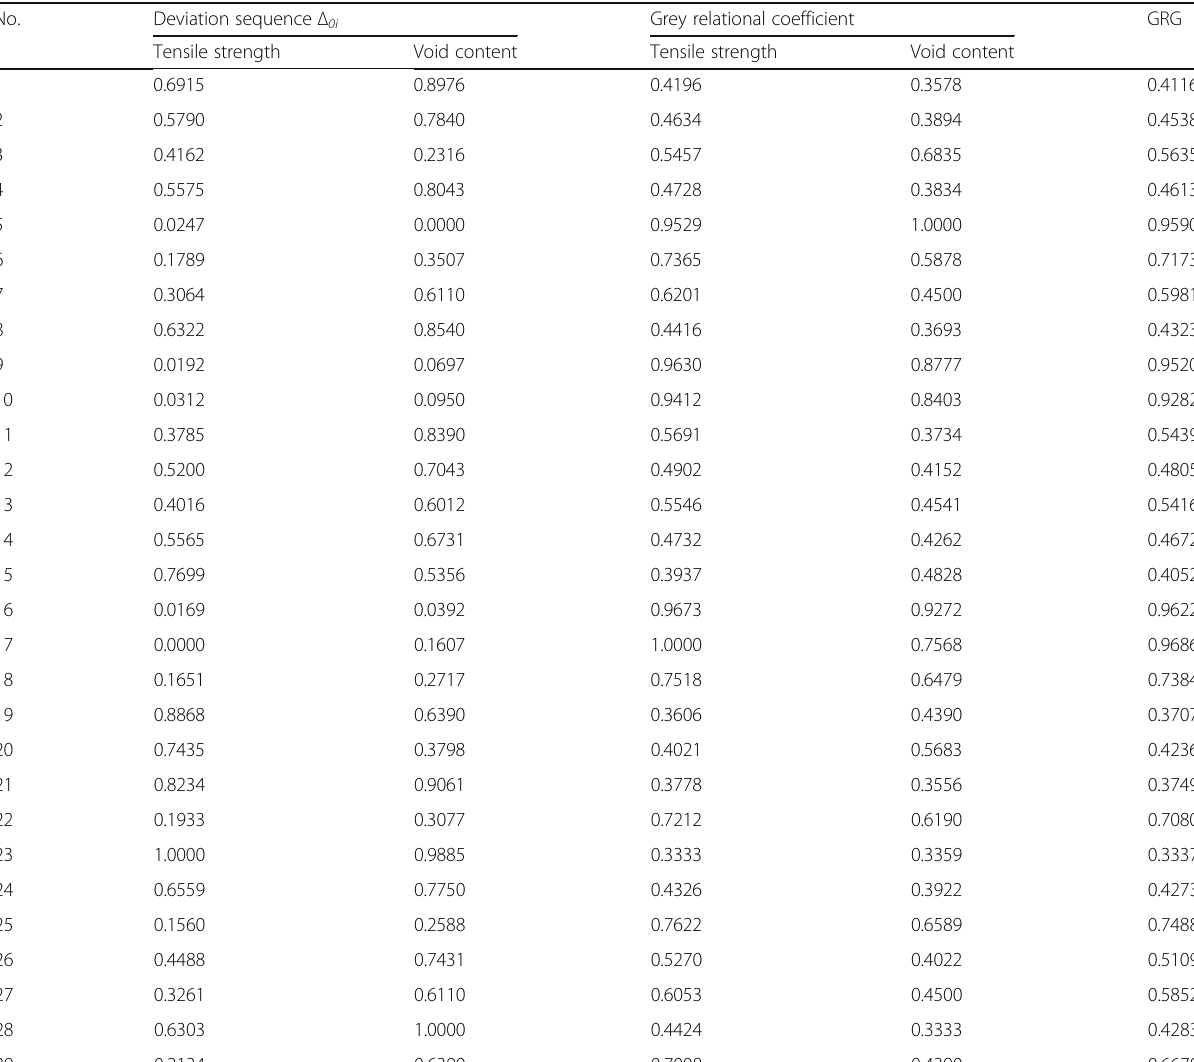
Table 3 Grey relational grade